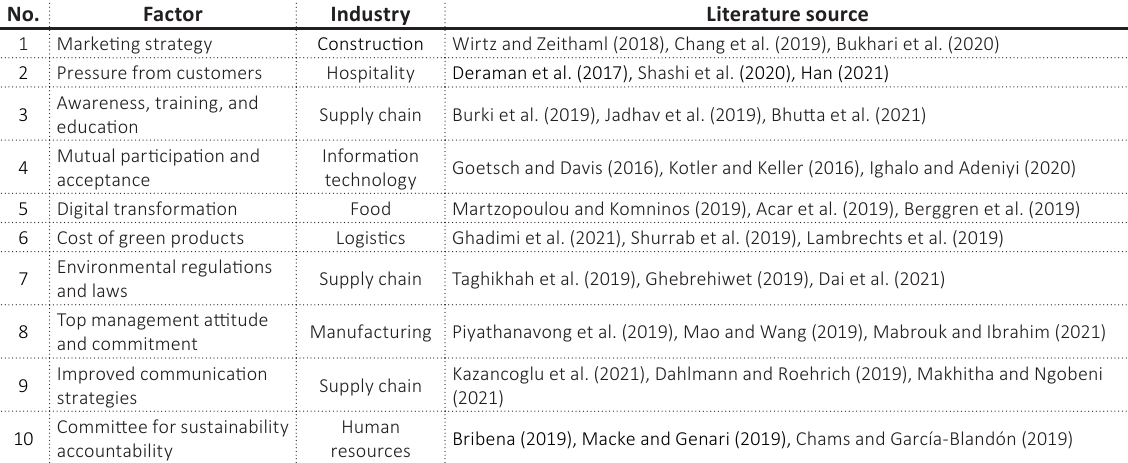
Table 1. Green initiatives implementation models and factors examined